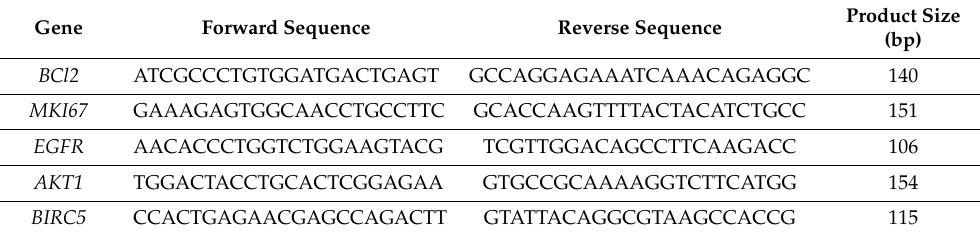
Table 1. Sequences of